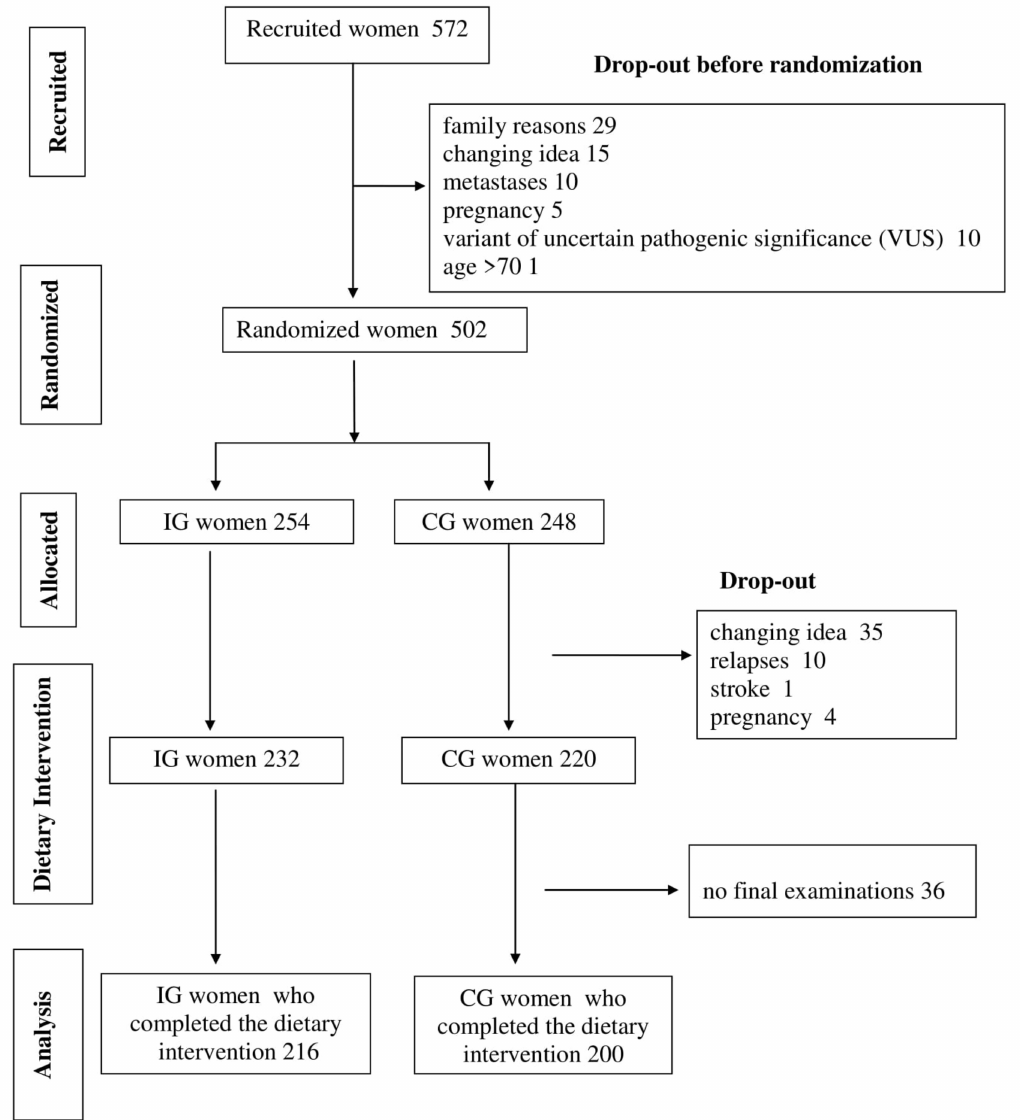
Figure 1. A flow chart of the trial. The flow chart, following Consolidated Standards of Reporting Trials CONSORT guidelines, describes the progress through the phases of our two-arm randomized controlled trial (recruitment, randomization, intervention allocation, dietary intervention and data